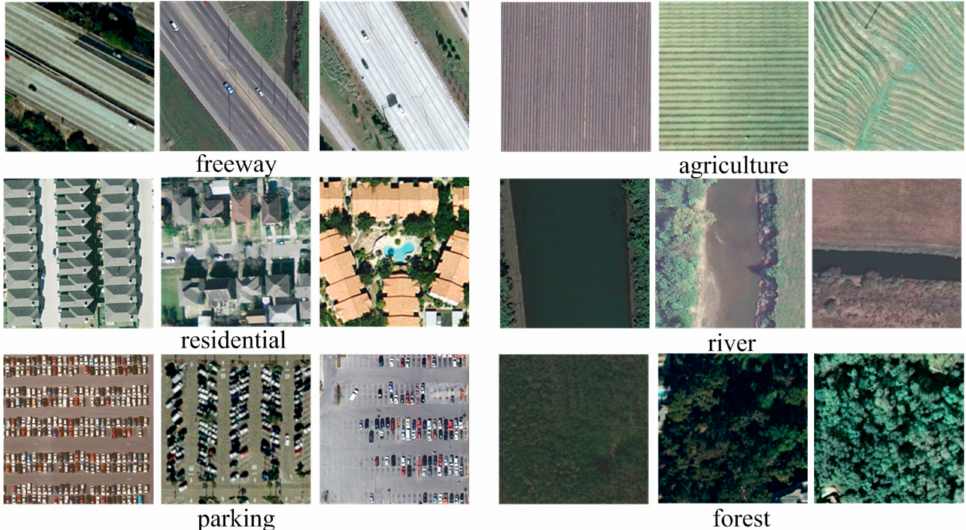
Figure 7. Sample images of the UC MERCED dataset in the source